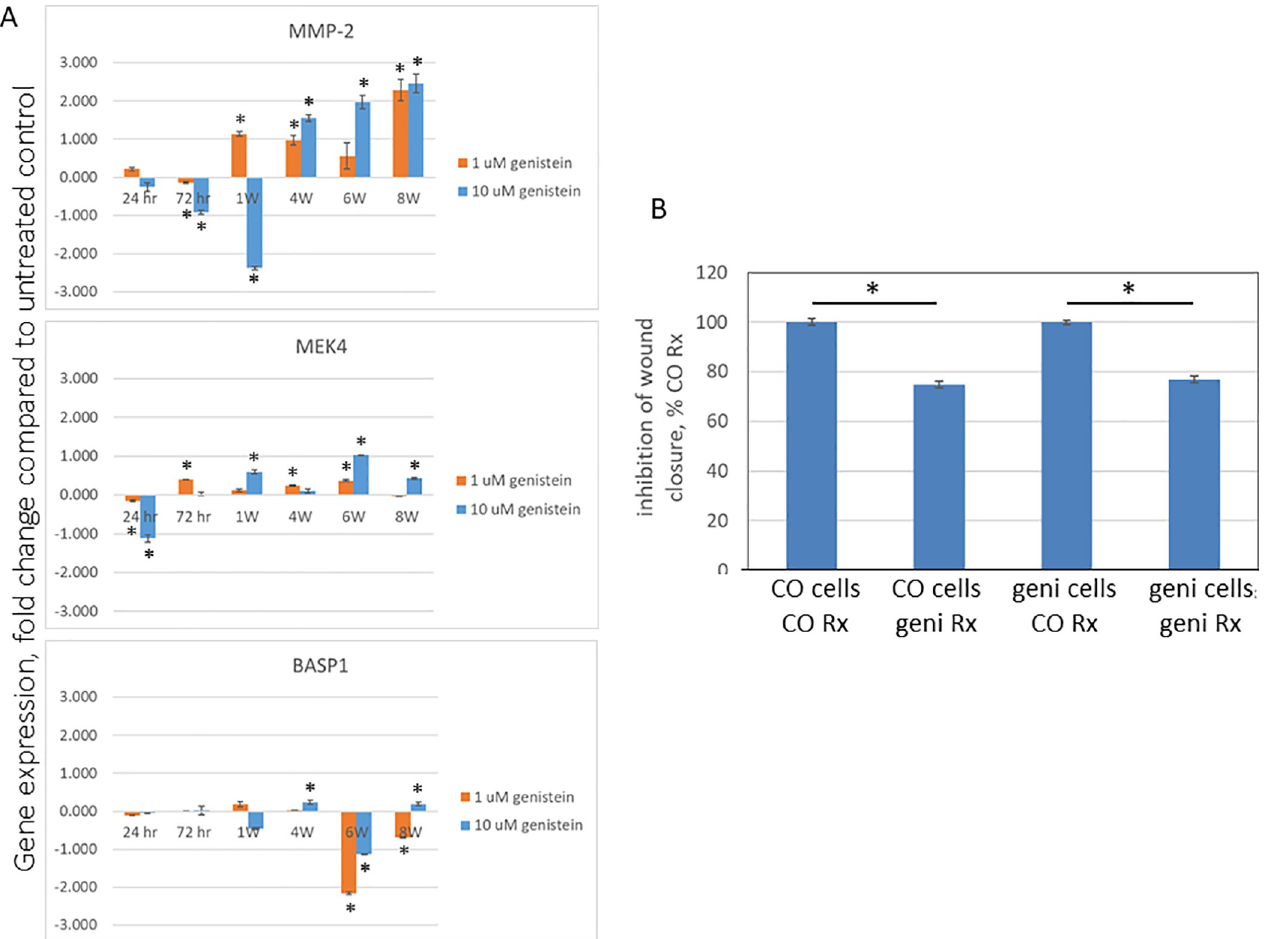
Fig 4. Long term genistein treatment alters biomarker response profile, but not therapeutic responsiveness. PC3 cells were cultured for the indicated times in the presence of either 1 or 10 μ M genistein, or equivalent vehicle for controls. A) Effect on gene expression. Cells were harvested at the indicated time points, expression of the indicated genes measured by qRT/PCR, normalized to that of GAPDH, and expressed as the fold difference of genistein treated to respective control cells. Data are the mean ± SEM of N = 3 replicates; with similar results seen in a separate experiment, also N = 3. � denotes Student’s t-test P-value < / = 0.05 between genistein and control cells at a given time point. B) Effect on cell migration. PC3 cells that had been treated with 10 μ M genistein for 8 weeks (geni cells), and vehicle control cells (CO cells), were cultured for 3 days in the absence of genistein/vehicle (i.e., a 3 day washout), treated with 10 μ M genistein (geni Rx) or vehicle control (CO Rx) for 3 days, and closure of wound gap measured, and expressed as a percentage of CO Rx for each of the cell types. Data are the mean ± SEM of N = 50 replicates; with similar results seen in a separate experiment, also N = 50. � denotes Student’s t-test P-value < / = 0.05 between the indicated